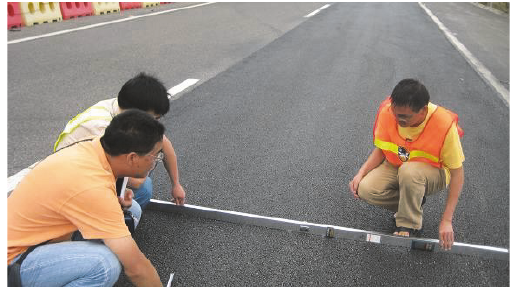
Figure 2: Smoothness